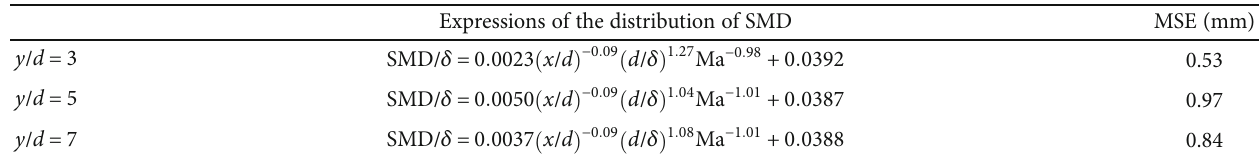
Table 7: Distribution of SMD and the corresponding MSE at the position of y / d = 3, 5, and7 . Expressions of the distribution of